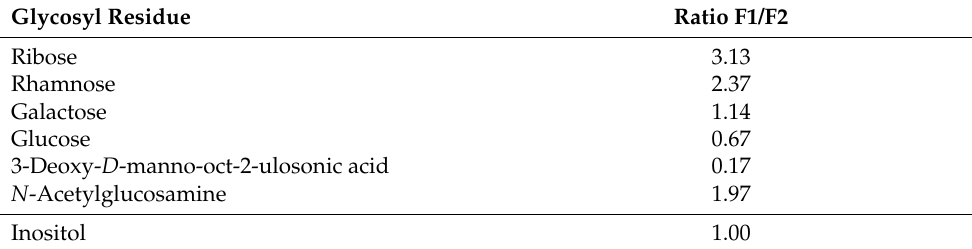
Table 2. Ratio (F1/F2) of the detected monosaccharide peak areas from the F1 and F2 fractions after normalizing to inositol. Ratios significantly > 1 indicate the monosaccharides are enriched in the higher molecular weight F1 fraction. Ratios significantly < 1 indicate the residues are enriched in the lower molecular weight F2 fraction.